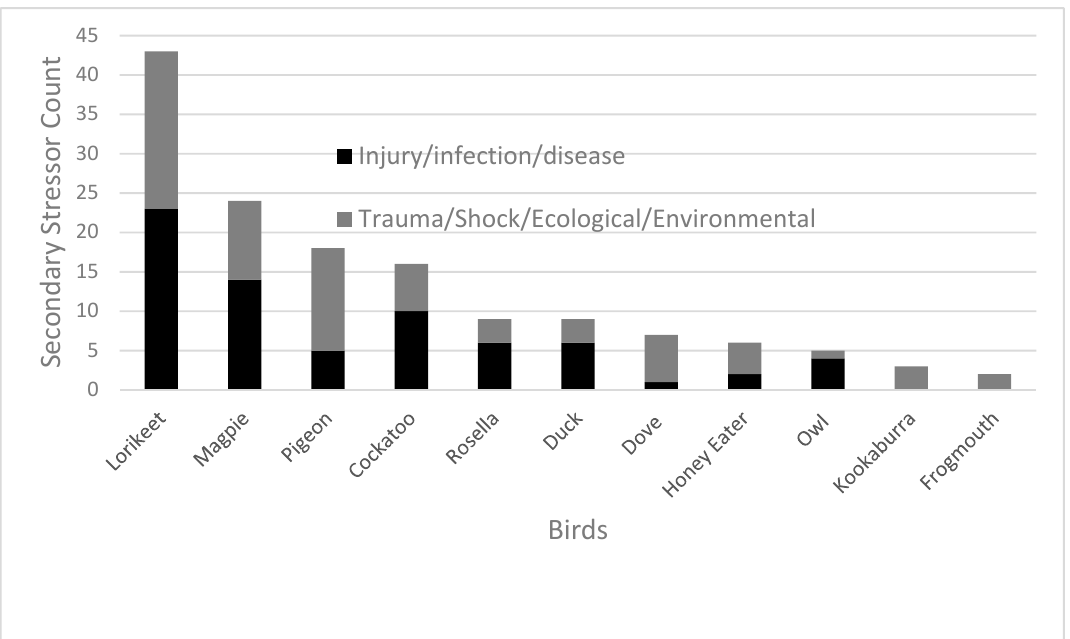
Figure 3. Key secondary stressors experienced by avian patients admitted to the Adelaide Koala and Wildlife Hospital in 2013, 2014, 2016 and 2017 ( n = 161). Note that birds presented to the hospital whose secondary stressor was unable to be identified ( n = 17) or those species with a cumulative count of only one secondary stressor were omitted from this figure. Secondary stressors were pooled into two categories. Injury / infection / disease-related secondary stressors comprised of factors such as fractures, dislocation, feather damage, broken bone etc. Trauma / shock / ecological / environmental-related primary stressors included factors such as severe dehydration, shock, shot, tissue damage from heat stress etc. Refer to Supplementary Table S1 to access raw data related to all bird patients.